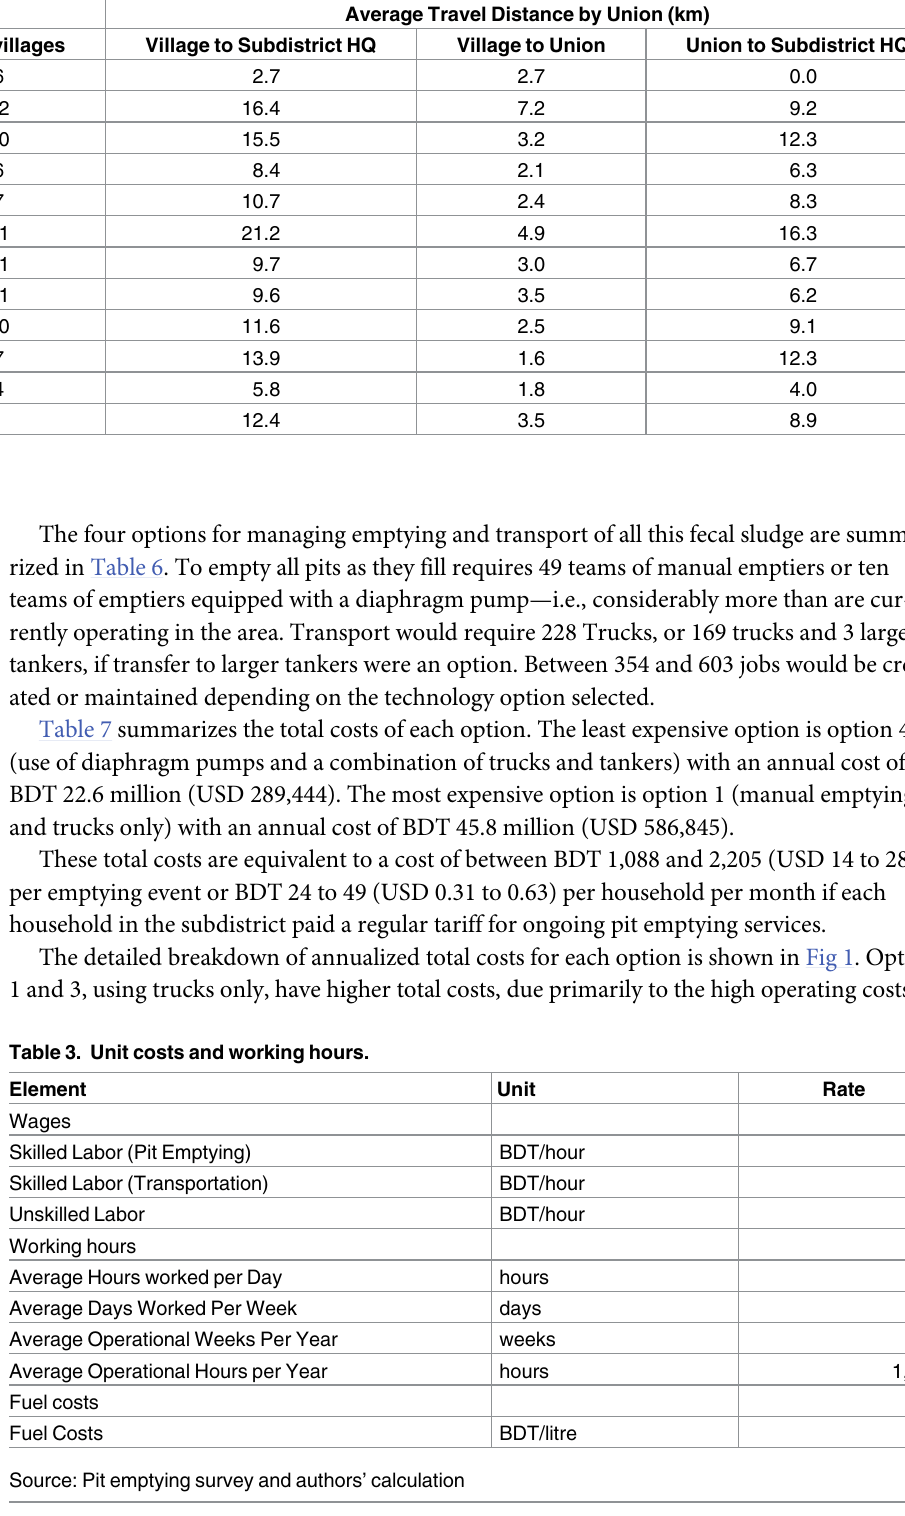
Source: Pit emptying survey and authors’